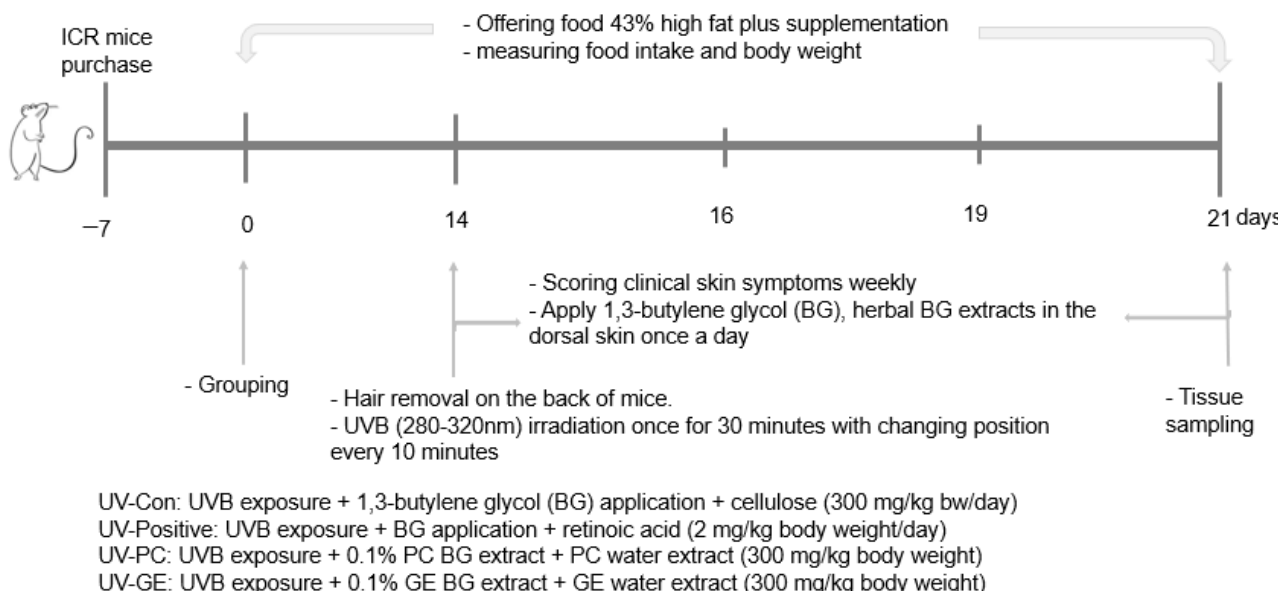
Figure 6. Experimental design.